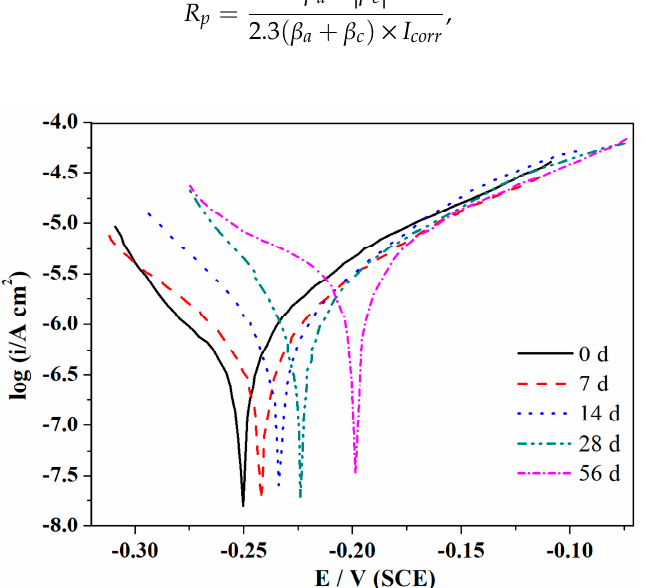
Figure 7. The polarization curves of Cu-Ni alloy after being exposed in corrosion solution for different days. Table 5. Characteristic parameters obtained from the polarization curves of the two alloys after being exposed in corrosion solution for different days.